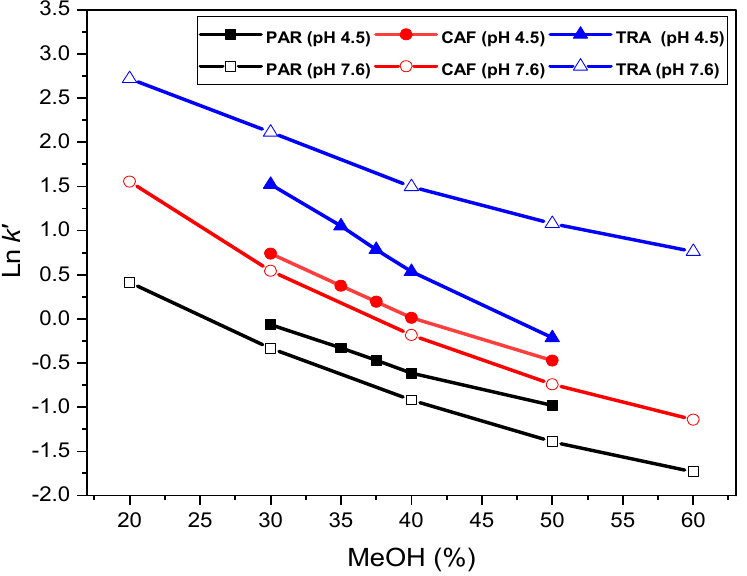
Figure 3. A plot of Ln k’ vs. % MeOH for paracetamol, caffeine and tramadol (peaks 1, 2 and 3, respectively as Figure 1).